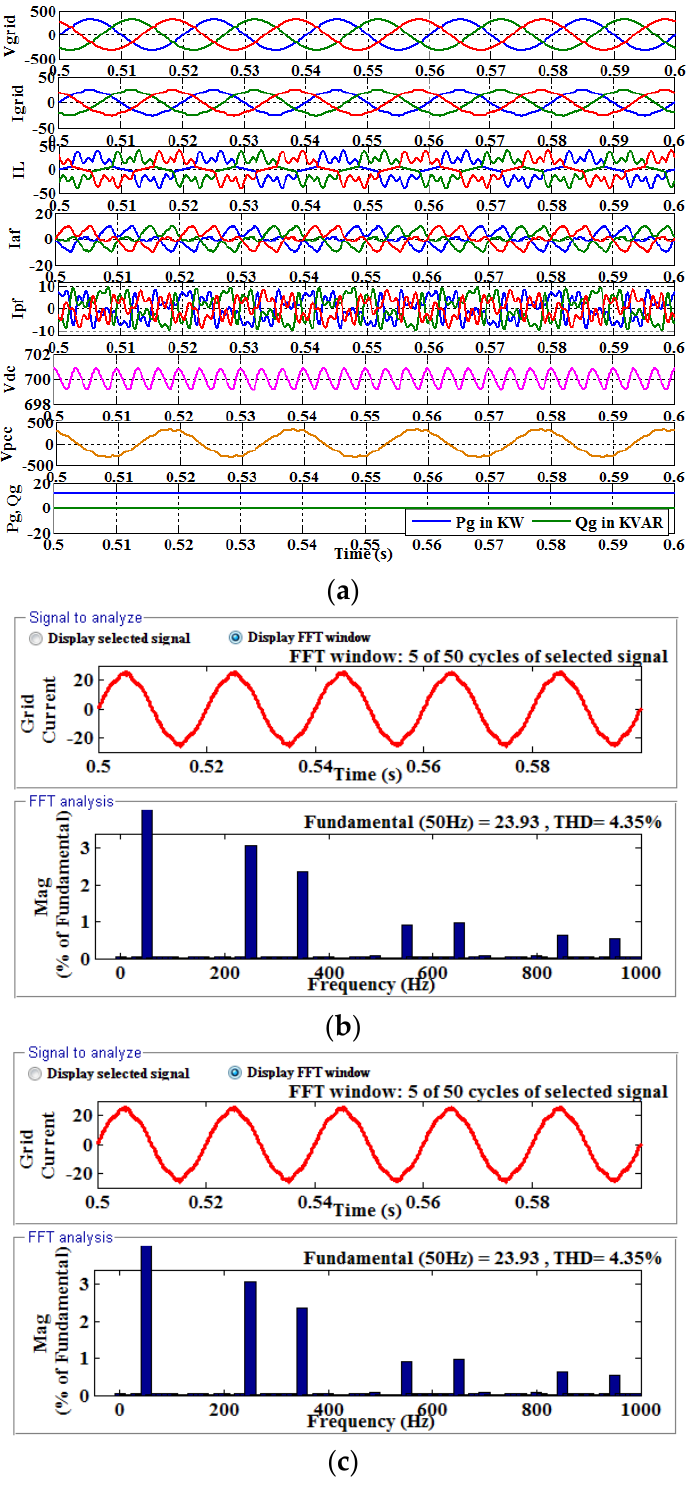
Figure 7. ( a ) Grid voltage and current, Load current, Injected active filter current, Injected passive filter current, DC link voltage, PCC voltage, Active and Reactive power drawn from the grid by the load connected at PCC for capacitive load in grid-connected mode, ( b ) FFT analysis of compensated grid current with a capacitive load, and ( c ) FFT analysis of compensated PCC voltage with capacitive